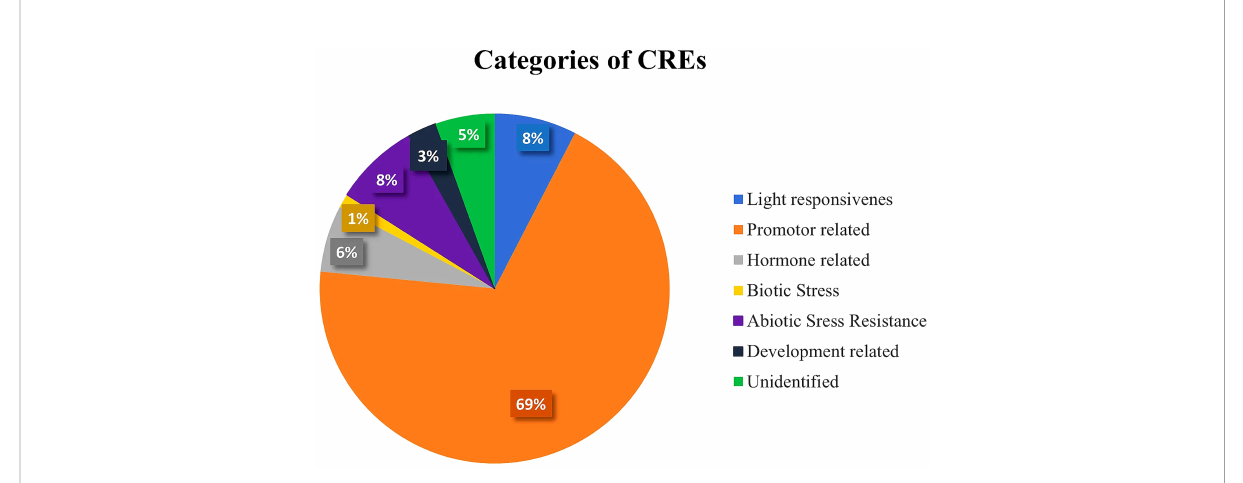
FIGURE 9 Pie chart representation of even categories of cis-regulatory elements with their respective percentages present in 58 SlDREB